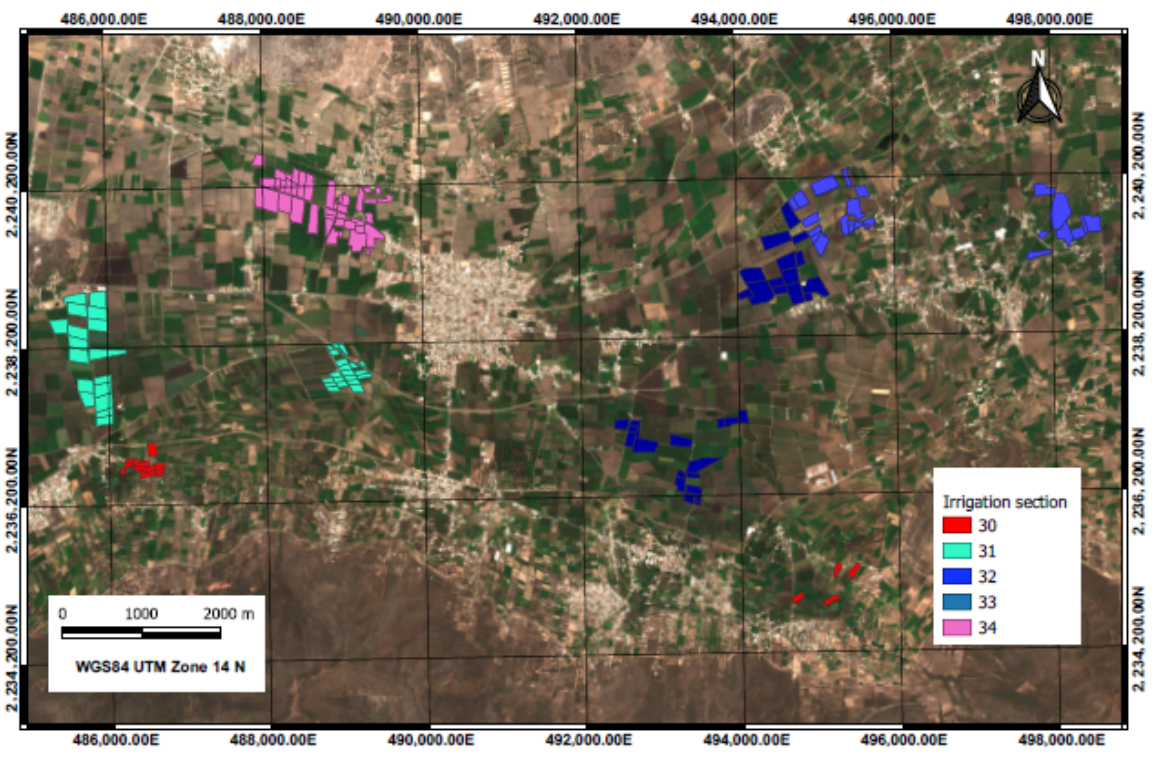
Figure 3. Map of sampling plots by irrigation section of the “Tepatepec” Irrigation Module in Irrigation District 03 “Tula”.